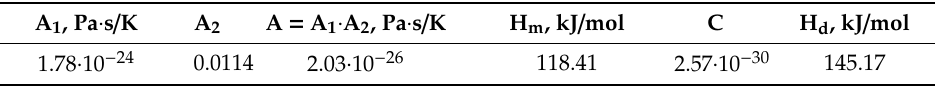
Table 1. Parameters of the She ffi eld equation of viscosity 1 for